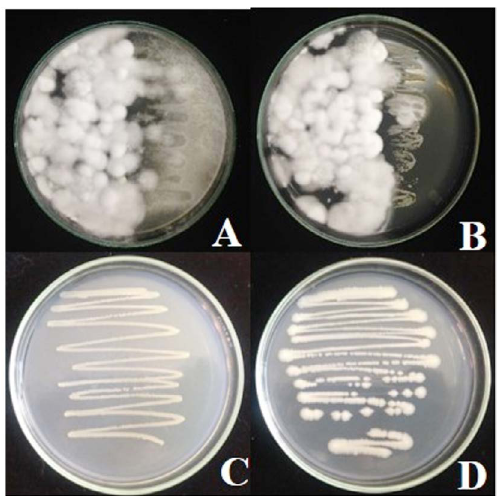
Fig. 3. Compatibility test of antagonistic bacteria B. pumilus FDKF5 or Bacillus sp. IKM1 and Trichoderma bio-product A: Trichoderma bio-products and Bacillus pumilus FDKF5 B: Trichoderma bio-products and Bacillus sp. IKM1 C: Re -streak of Bacillus pumilus FDKF5 D: Re -streak of Bacillus sp. IKM1